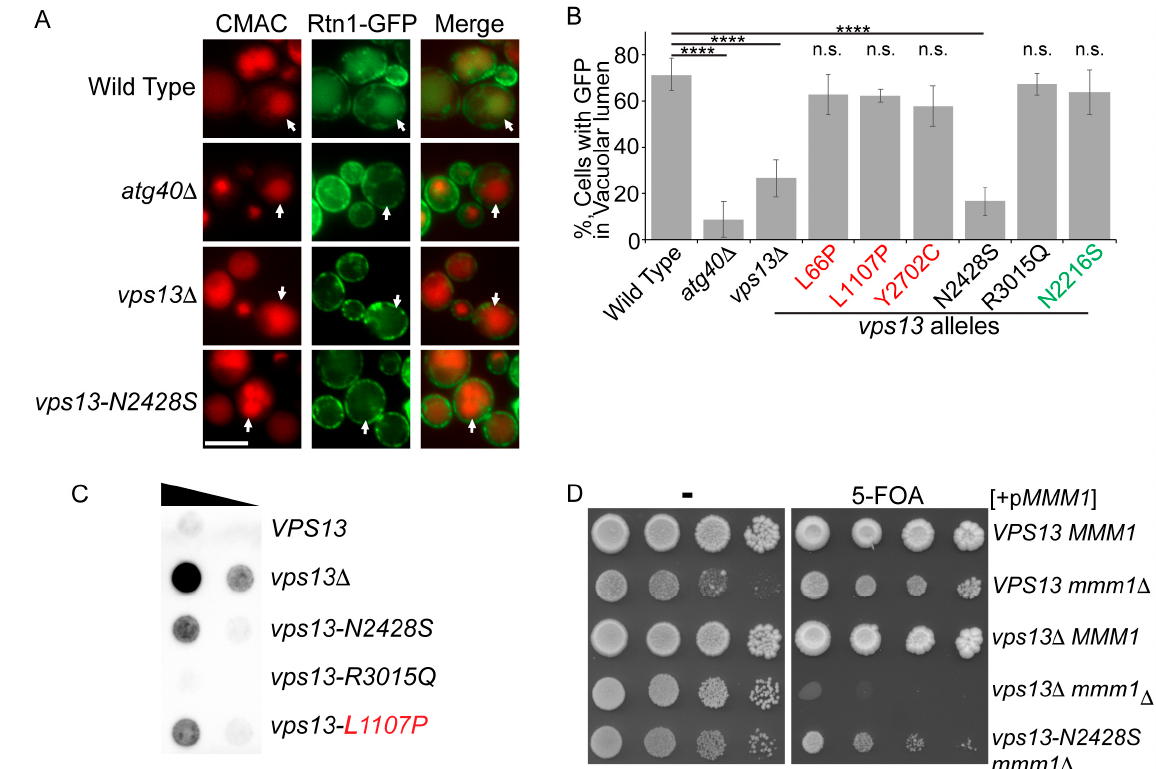
Figure 3. Characterization of the vps13-N2428S allele. ( A ) ER-phagy: cells at mid-log phase were treated with rapamycin for 16 h and stained with the dye CMAC to indicate the position of the vacuole. ER-phagy results in the co-localization of the cortical ER protein, Rtn1-GFP, with the vacuole. Wild type (GCY5), atg40 ∆ (JSP845), vps13 ∆ (JSP846) and vps13-N2428S (JSP851). Arrows highlight the positions of the vacuole in representative cells as shown by CMAC fluorescence (in red). Scale bar = 5 µ m. ( B ) The fraction of cells exhibiting Rtn1-GFP fluorescence in the vacuolar lumen after rapamycin treatment in different VPS13 mutants; strains as in ( A ), plus vps13-L66P (JSP847), vps13-L1107P (JSP848), vps13-Y2702C (JSP849), vps13-R3015Q (JSP852), and vps13-N2216S (JSP854). Numbers are the averages of at least three independent experiments with over 150 cells per strain scored in each experiment. Error bars indicate one standard deviation. **** indicates p < 0.0001, Student’s t -test, n.s. not significant. ( C ) CPY secretion assay. Cells were grown to exponential phase in liquid YPD, adjusted to equalize cell numbers between cultures and ten-fold dilutions were spotted onto SD complete medium. A nitrocellulose membrane was placed over the cells and the plates were incubated overnight at 30 ◦ C. The filter was then rinsed and probed with anti-CPY antibodies. Strains used were wild type (BY4741), vps13 ∆ (KO1), vps13-N2428S (JSP757), vps13-R3015Q (JSP758), and vps13-L1107P (RP202). ( D ) Synthetic lethality assay with mmm1 ∆ . Strains of the indicated genotype carrying pRS316- MMM1 were grown overnight at 30 ◦ C in YPD medium; wild type (BY4741), mmm1 ∆ (JSP441), vps13 ∆ (KO1), vps13 ∆ mmm1 ∆ (JSP443) and vps13-N2428S mmm1 ∆ (JSP759). Tenfold serial dilutions were spotted onto SD complete medium with or without 5-FOA and grown at 30 ◦ C for 4 days. Color code for allele designations as in Figure